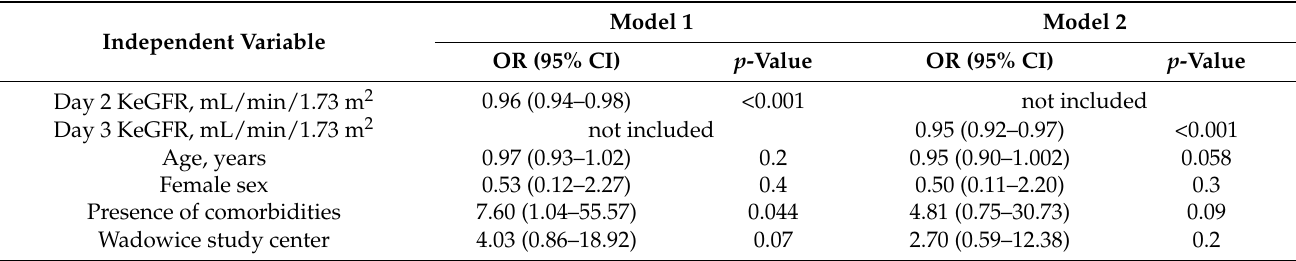
Table 7. Multiple logistic regression model to predict severe acute pancreatitis (SAP). Adjusted odds ratios (OR) are reported per 1 unit increase in the value of independent